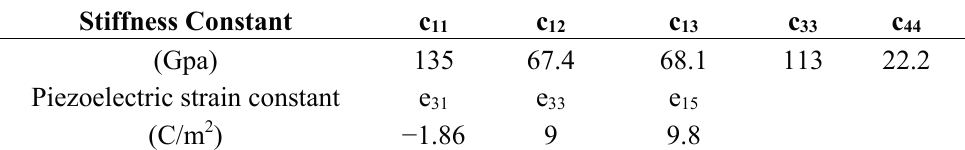
Table 3. Elastic matrix parameters and piezoelectric matrix parameters of